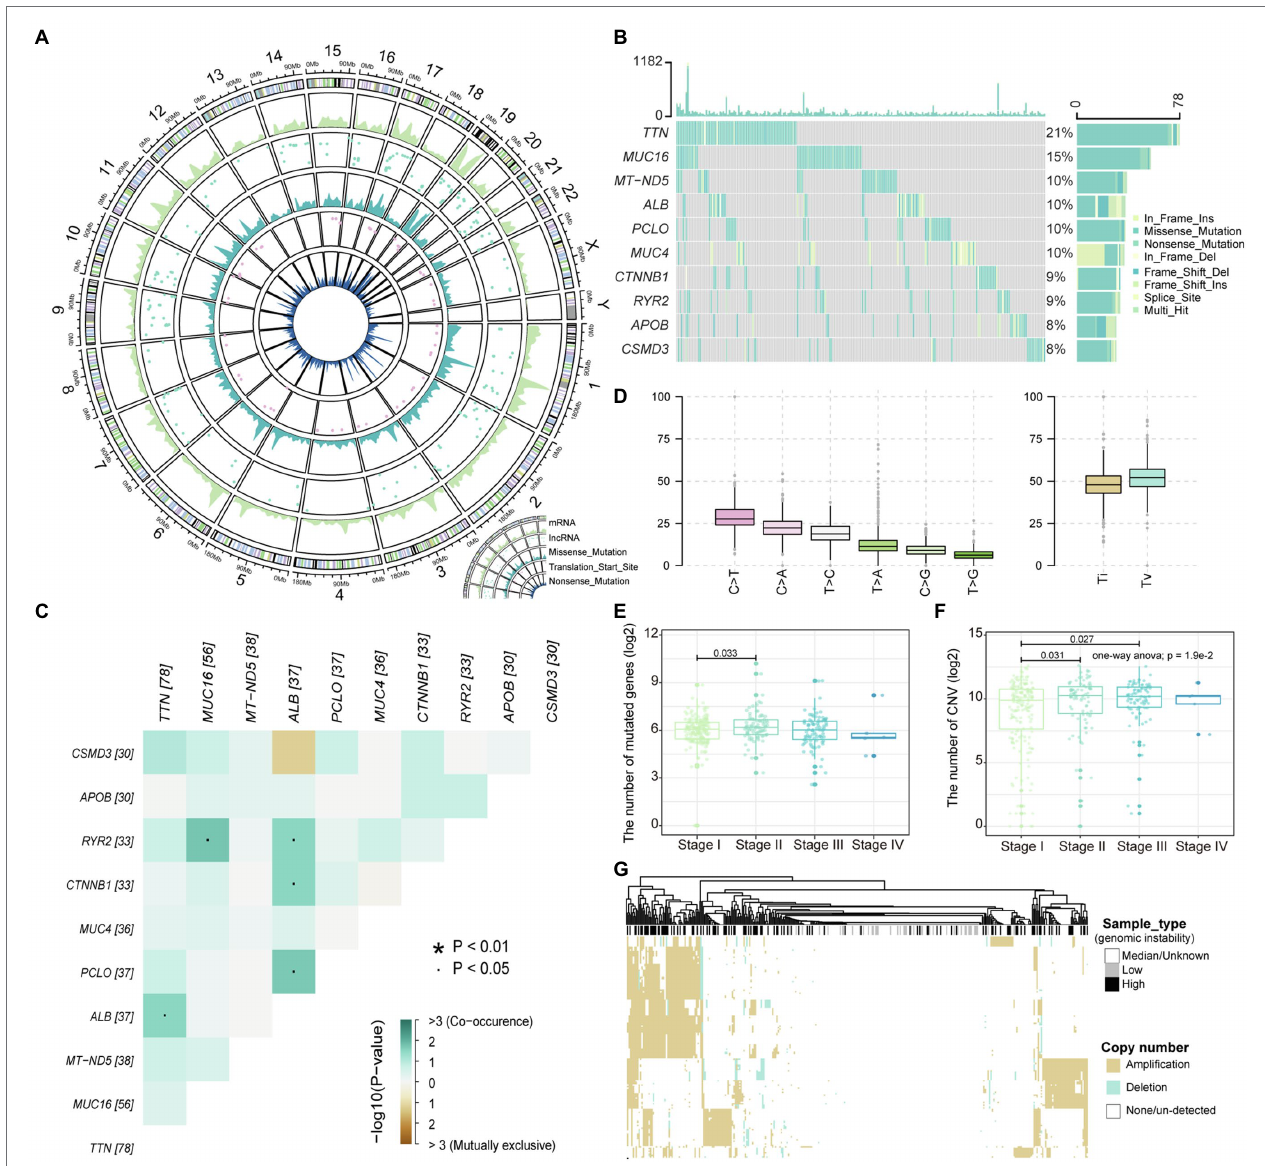
FIGURE 1 | The landscape of liver hepatocellular carcinoma (LIHC) somatic variations. (A) The density distribution of somatic mutations on chromosomes. The four-layer circle plot shows the density distribution of nonsense mutations, mutations of transcription start site, missense mutations, mutations of long-noncoding RNA (lncRNA), and mutations of mRNA on chromosomes from inside to outside. (B) The waterfall plot shows the top 10 genes in terms of mutation frequency by sample. The mutation type of each gene in each sample is marked. (C) Mutation correlation heatmap of the top 10 high-frequency mutated genes. Locations with significant correlations are marked by stars. (D) Boxplot shows the frequency of base substitutions including transversion and transition. (E,F) The relationship between the number of mutated and copy number variation (CNV) genes in each sample and the stage are displayed with boxplot. The number of mutated and CNV genes is logarithmized, and the rank sum test is used to assess differences between groups. (G) The copy number amplitudes of tumor samples are presented in heat map. Column labels show sample types, including high/low-genomic instability and